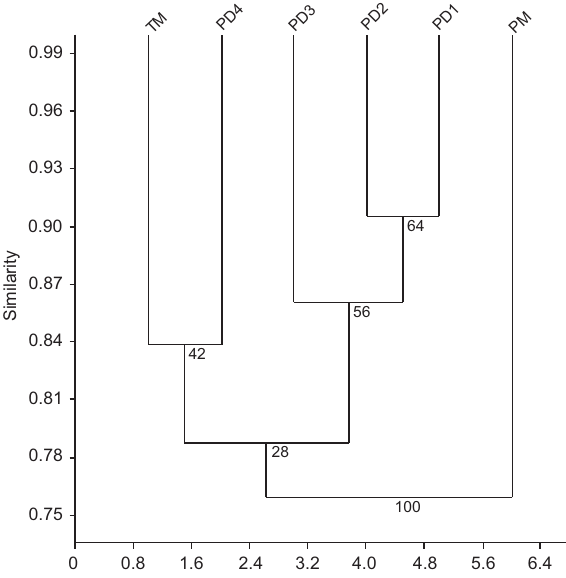
Figure 3. Similarity between breeding ponds in relation to envi-